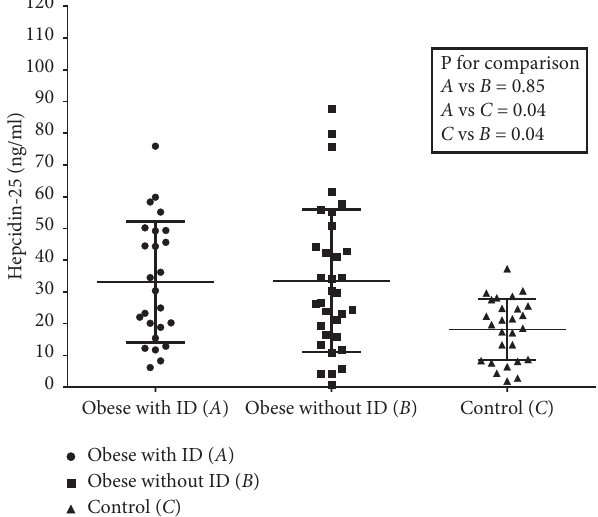
Figure 2: Comparisons of serum hepcidin-25 between three